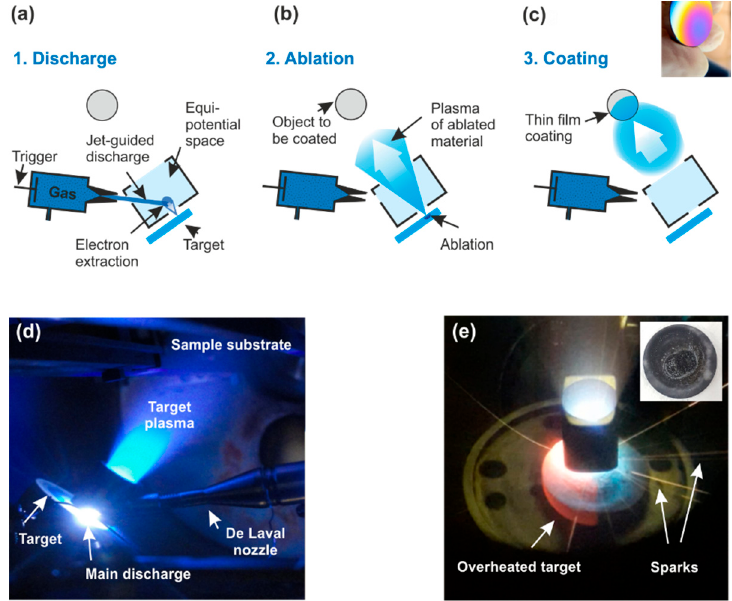
Figure 1. ( a – c ) Schematic sketch of the three main steps of ionized jet deposition (IJD) for thin film growth; ( d ) Photograph of the IJD chamber illustrating main discharge and target plasma during deposition with optimized operating parameters (discharge frequency f = 150 Hz, acceleration voltage V = 15 kV); ( e ) Photograph showing target overheating and formation of sparks during deposition with f > 250 Hz and/or V > 18 kV; the inlet displays a top view of the target’s surface after deposition with V = 18 kV.